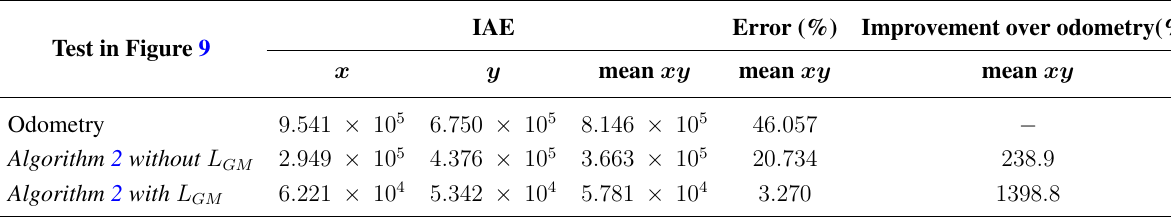
Table 2. IAE performance and percentage errors for the 30 min run, differential robot. Test in Figure 9